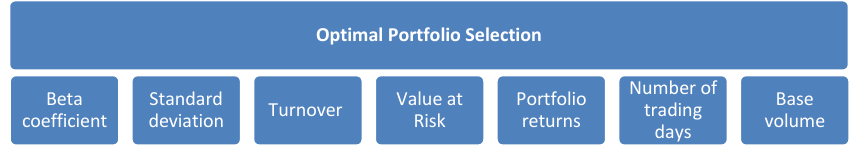
Figure 1. Graph of proposed variables